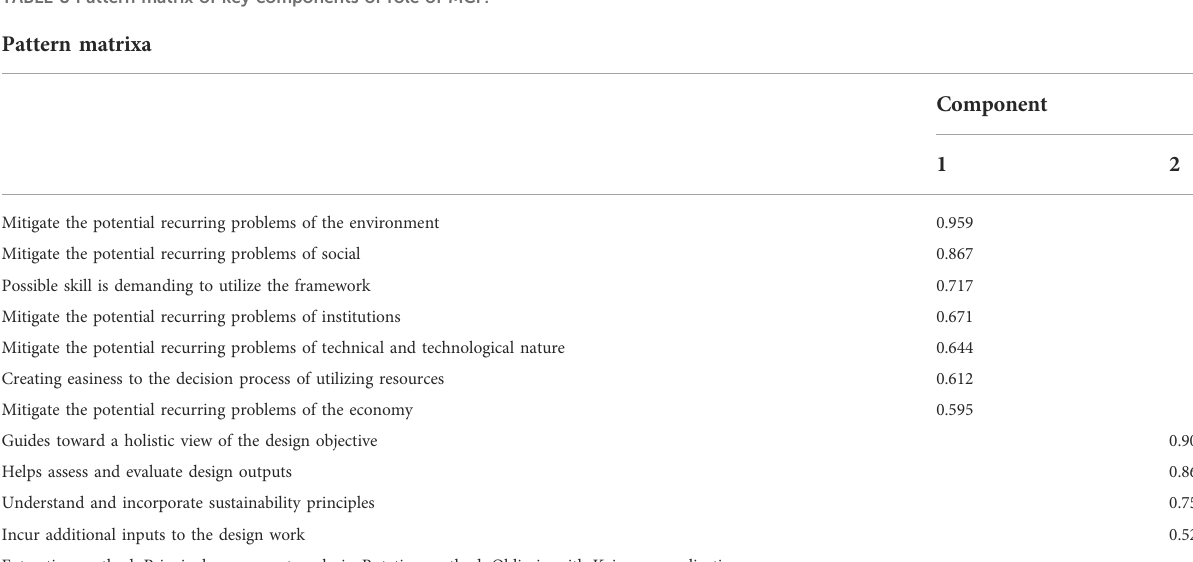
TABLE 8 Pattern matrix of key components of role of